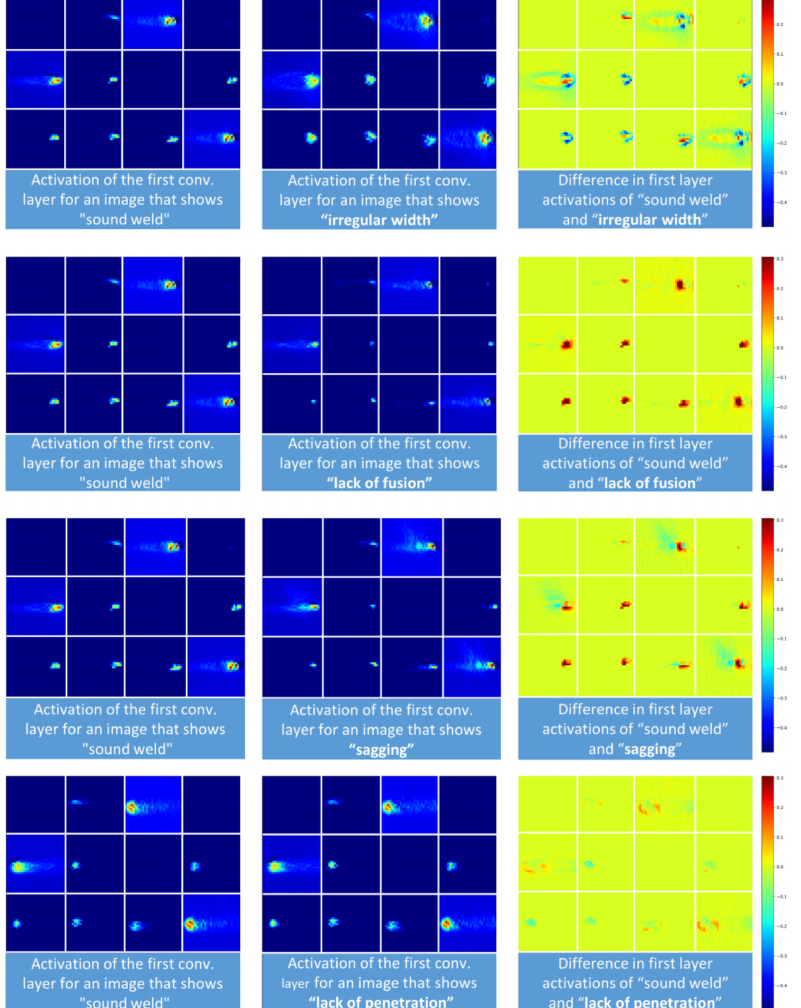
Figure 8. Layer activations based on 12 different filter kernels in the first layer of a CNN that was trained to recognize welding defects based on images from the MWIR camera. Each square shows a single activation